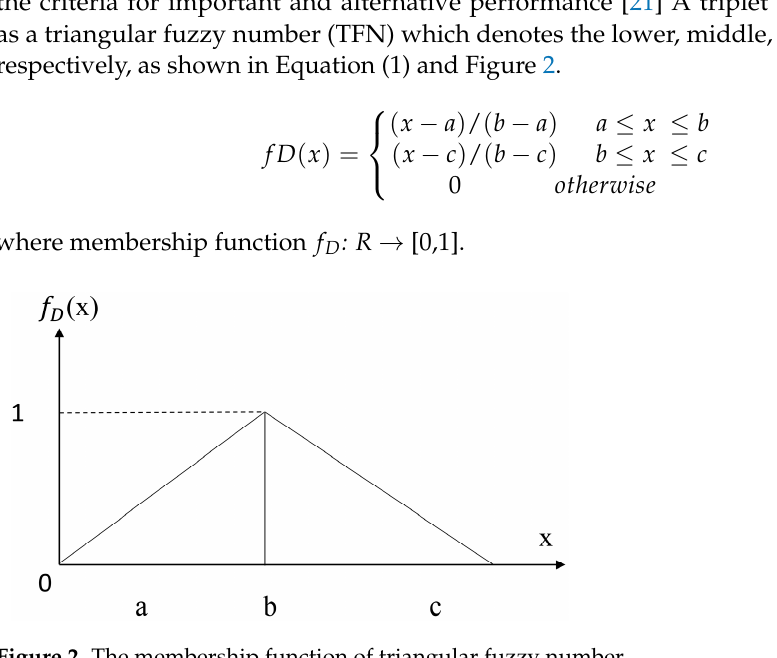
Figure 2. The membership function of triangular fuzzy